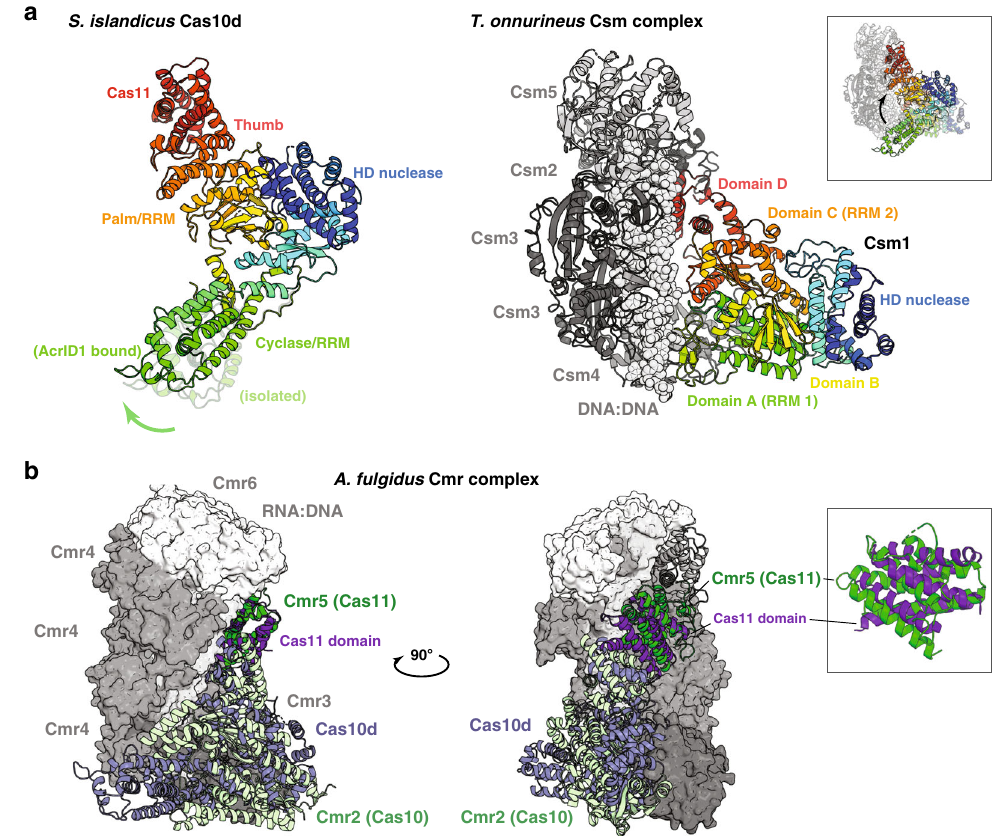
Fig. 5 Comparison of Cas10d to type III effector complexes. a Left, structure of S. islandicus Cas10d (this work) coloured in rainbow from blue (N terminus) to red (C terminus) with individual domains indicated and the conformation of the fl exible Cyclase/RRM domain observed in the isolated structure of Cas10d shown in faint colours ( “ isolated ” ); Right, structure of the intact T. onnurineus Csm complex consisting of Csm1, Csm2, two copies of Csm3, Csm4, Csm5, and DNA as determined by cryo-EM (PDB ID 6MUT) 41 . The Csm1 subunit, which is homologous to Cas10d, is coloured using the same colour scheme. The inset shows an overlay of Cas10d and the Csm complex with an arrow indicating the putative shift of the Cyclase/RRM domain in Cas10d when bound to the backbone complex. b Structure of the A. fulgidus Cmr complex (PDB ID 3X1L) bound to a DNA:RNA hybrid substrate, consisting of Cmr2 (Cas10, light green) and Cmr5 (Cas11, dark green) in cartoon, and Cmr3 (Cas5), three copies of Cmr4 (Cas7), two copies of and Cmr6 (Cas7), and DNA/RNA shown as a grey surface. Superimposed on this, the structure of S. islandicus Cas10d (pale blue) with the Cas11 domain in purple 40 . The inset highlights the homology between Cmr5 and the Cas10d Cas11 domain (rmsd 7.5 Å over 610